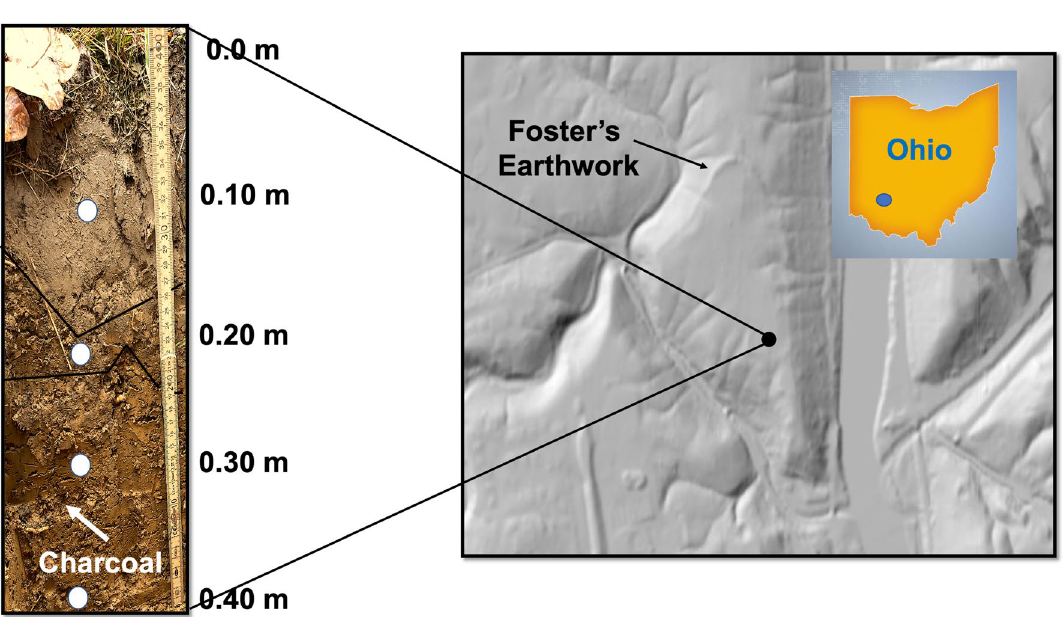
Figure 9. The location, stratigraphy, and sediment sample sites (white circles) of the Fosters Crossing earthworks site, Warren County, Ohio. Kenneth Barnett Tankersley used Microsoft PowerPoint for Mac Version 16.41 (www. micro soft. com) to create this figure. The GIS map was produced in ESRI ArcGIS 10.3.1 software (www. esri.